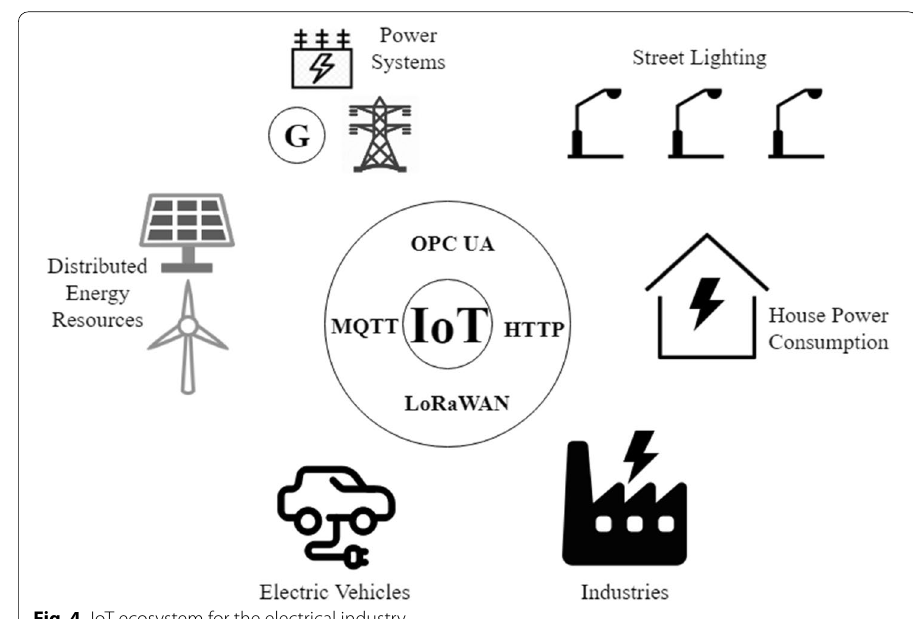
Fig. 4 IoT ecosystem for the electrical